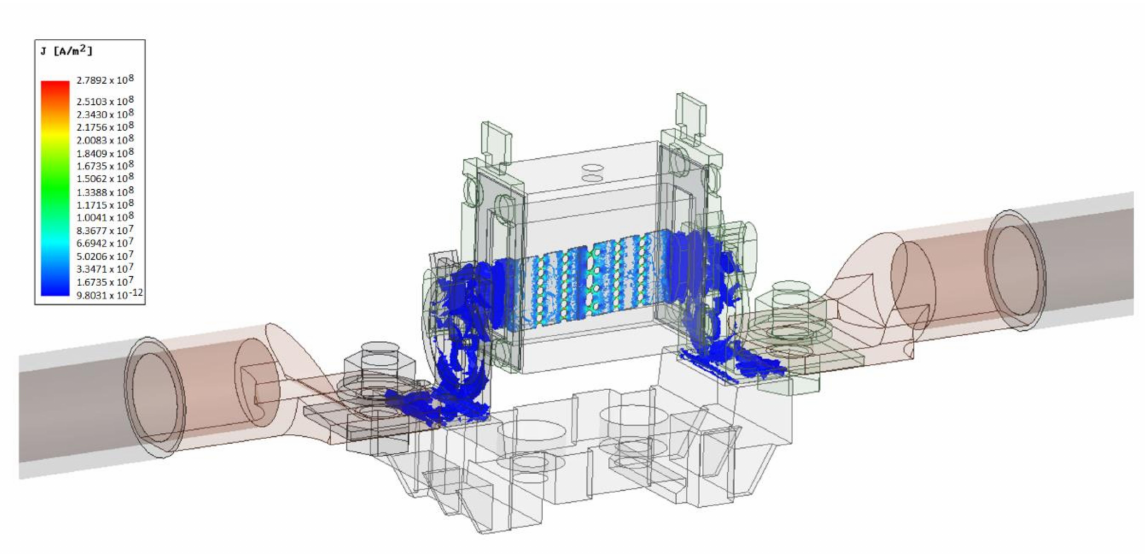
Figure 8. Distribution of the current density on the current circuit elements of the fuse model for a rated current of 100 A.